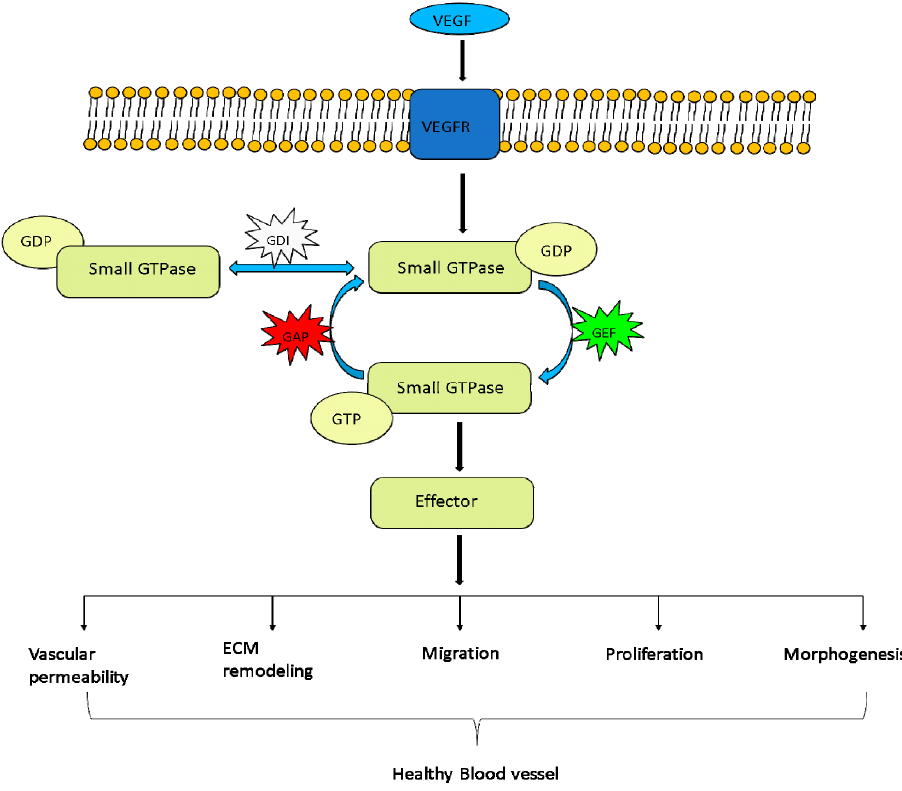
Figure 1. Small GTPase regulation leading to healthy vessels: Cycling of GTPases in the active state and inactive state. Their activation is governed by GEFs, which remove GDP and allow excess cy- toplasmic GTP to attach. The binding of active GTPase to effector proteins aggravates the cell re- sponse to give rise to blood vessels. GAP, by increasing GTPase activity, turns off the switch for GTPases. Inactive GTPase aggregates in the cytosol via GDIs. By activating effector proteins, downstream processes led to the development of healthy blood vessels. (adapted and modified from Cherfils and Zeghouf., 2013 [10]